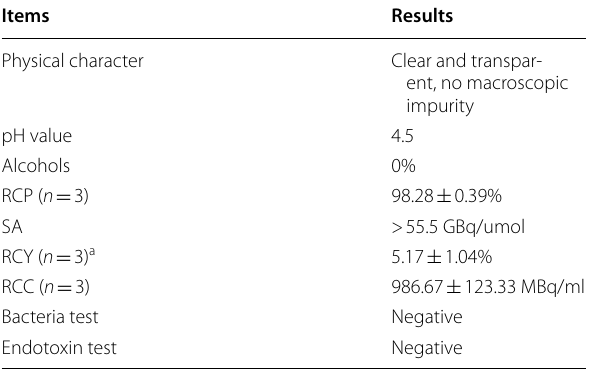
Table 1 Characterization and quality control of 18 F-deoxy-